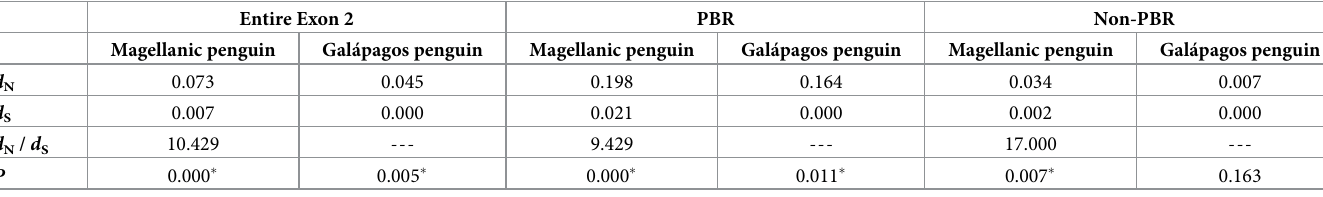
Table 3. Summary of substitution tests for selection at the MHC class II DR β 1-like gene for the entirety of exon 2, the peptide-binding region (PBR), and the non- peptide-binding region (Non-PBR). Nonsynonymous substitution rate ( d N ), synonymous substitution rate ( d S ), and P -values ( P ) for the Z-test of selection of positive selection are presented.